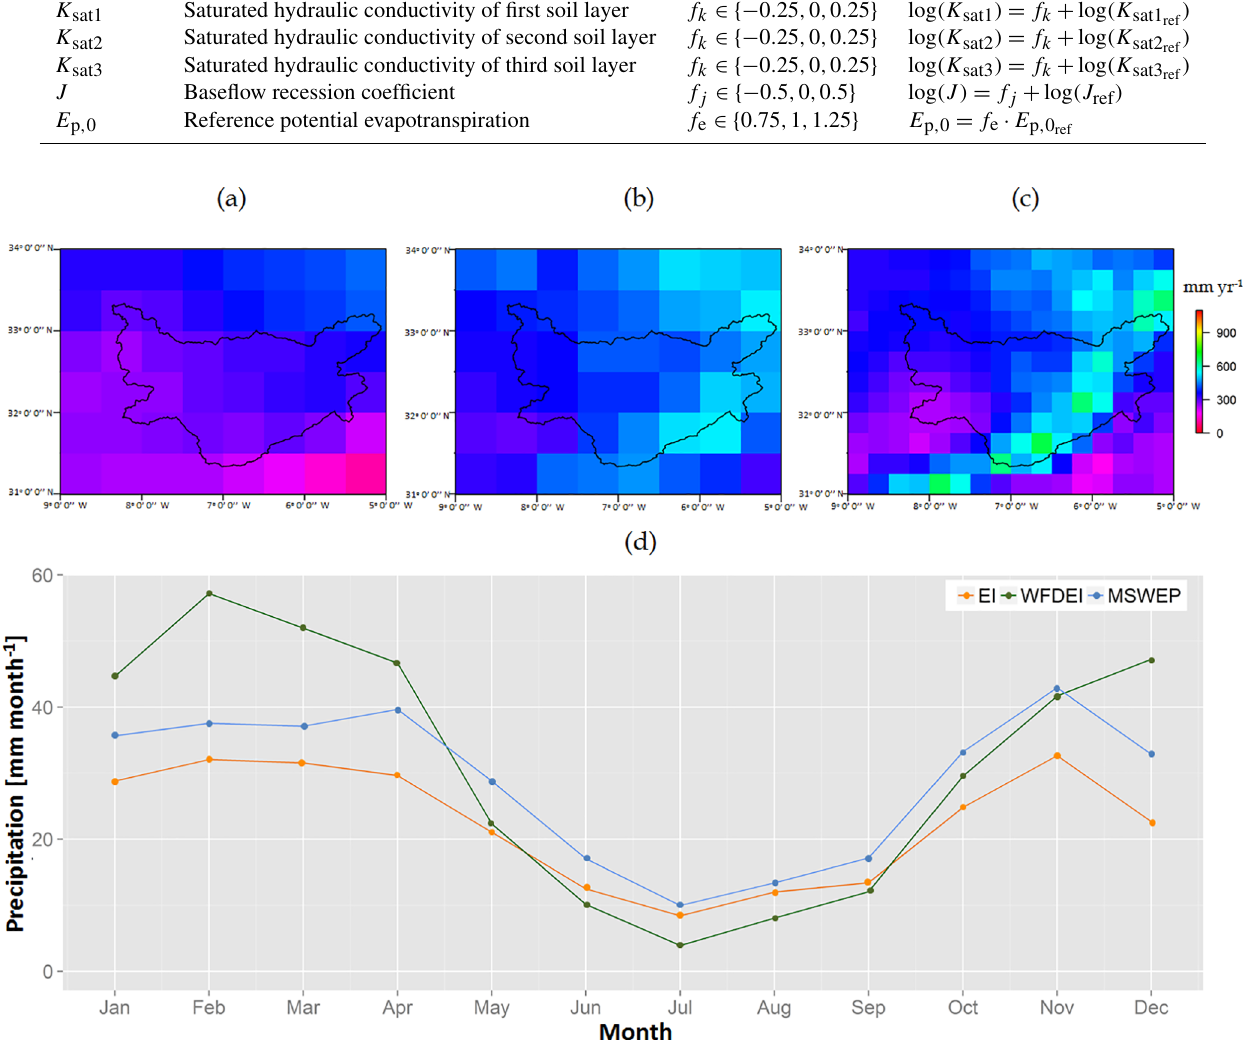
Figure 3. (a) EI annual mean precipitation, (b) WFDEI annual mean precipitation and (c) MSWEP annual mean precipitation for 1979–2010 time period and (d) climatology of EI, WFDEI and MSWEP precipitation